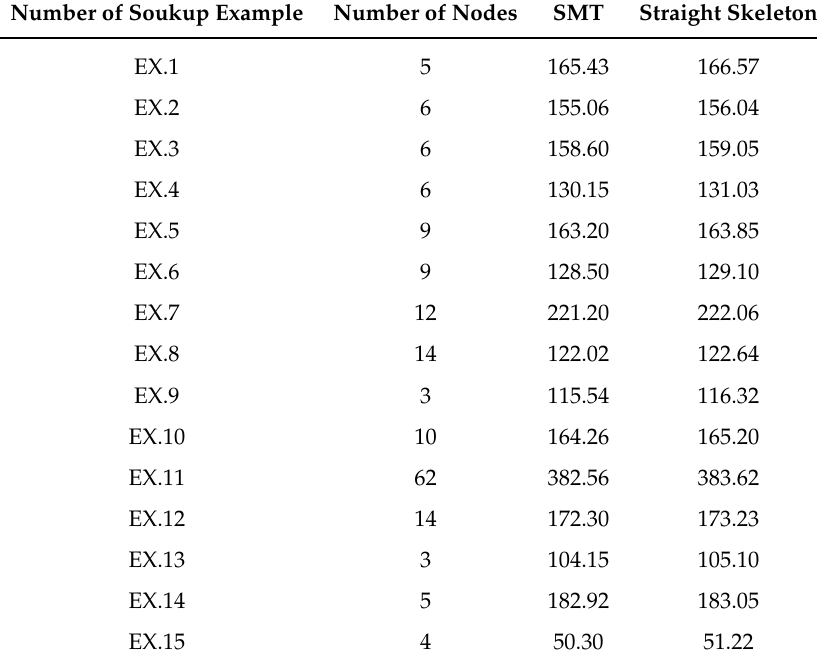
Table 3. Steiner Minimal Tree (SMT) vs. Straight